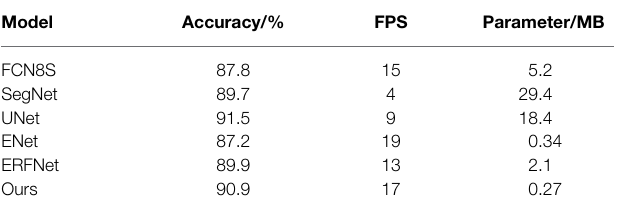
TABLE 1 | Performance comparison of different models.